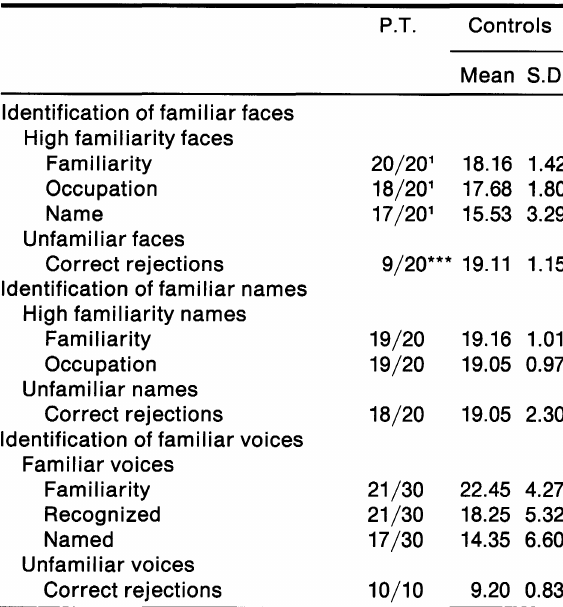
TABLE II. P.T.'s ability to recognize familiar people from face, name or voice